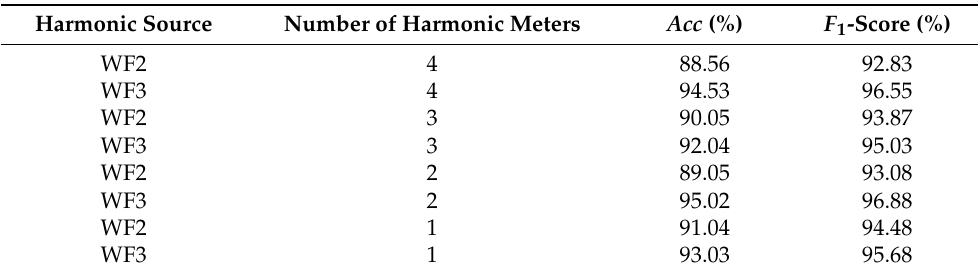
Table 8. Harmonic source locators’ accuracy and F 1 ‐ score for WF2 and WF3 in the Tasmanian transmission network.